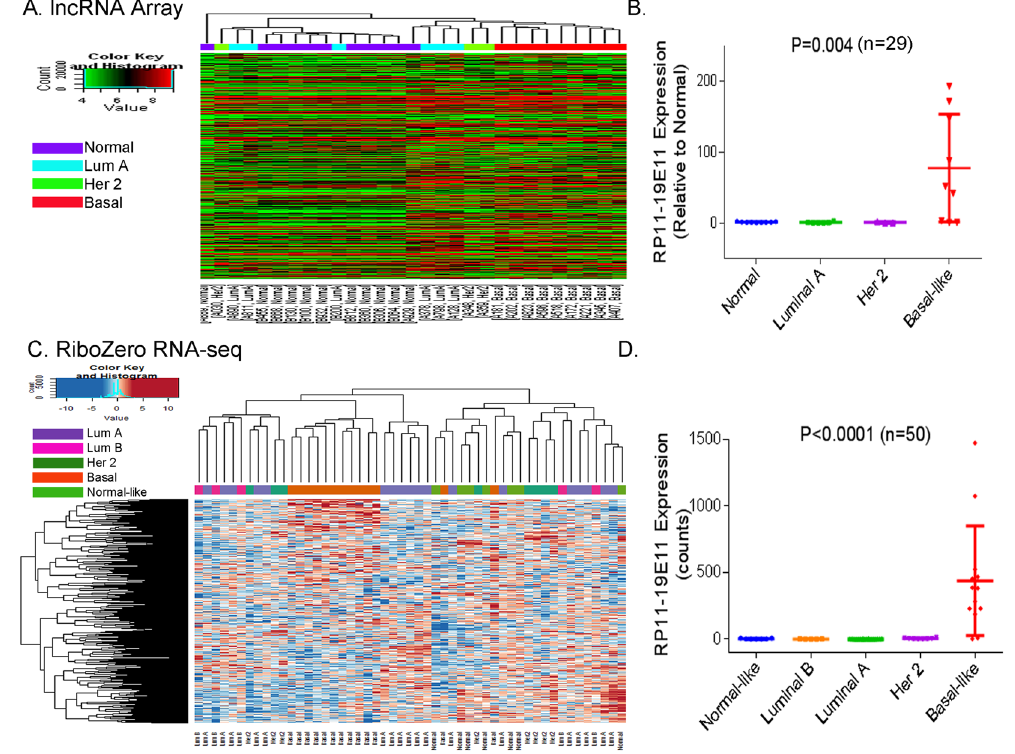
Figure 1. BLAT1 Expression is Highly Up-Regulated in Basal-like Breast Tumors. LncRNA expression was profiled through human lncRNA array ( A ) or RiboZero RNA-sequencing ( C ). Unsupervised hierarchical clustering of lncRNA expression shows a unique lncRNA expression signature of BLBC tumors compared to non-BLBC tumors ( A , C ). Both lncRNA array and RNA-seq data identified RP-11-19E11.1 (BLAT1) as a significantly up-regulated lncRNA in BLBC tumors, compared to normal breast tissues and other subtype tumors ( B , D